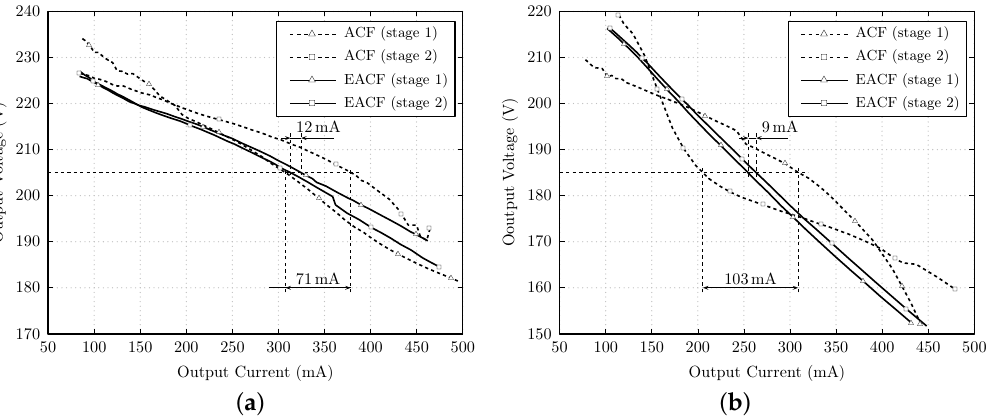
Figure 12. Experimental output voltage to output current curves for stages 1 and 2 in the ACF topology (dotted line) and EACF topology (solid line) for different values of the resonant inductor: ( a ) L r = 1µH; ( b ) L r =